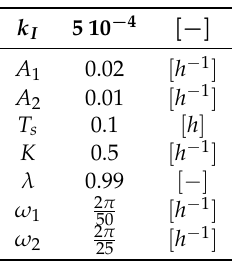
Table 4. Block-oriented model RLS-ES controller